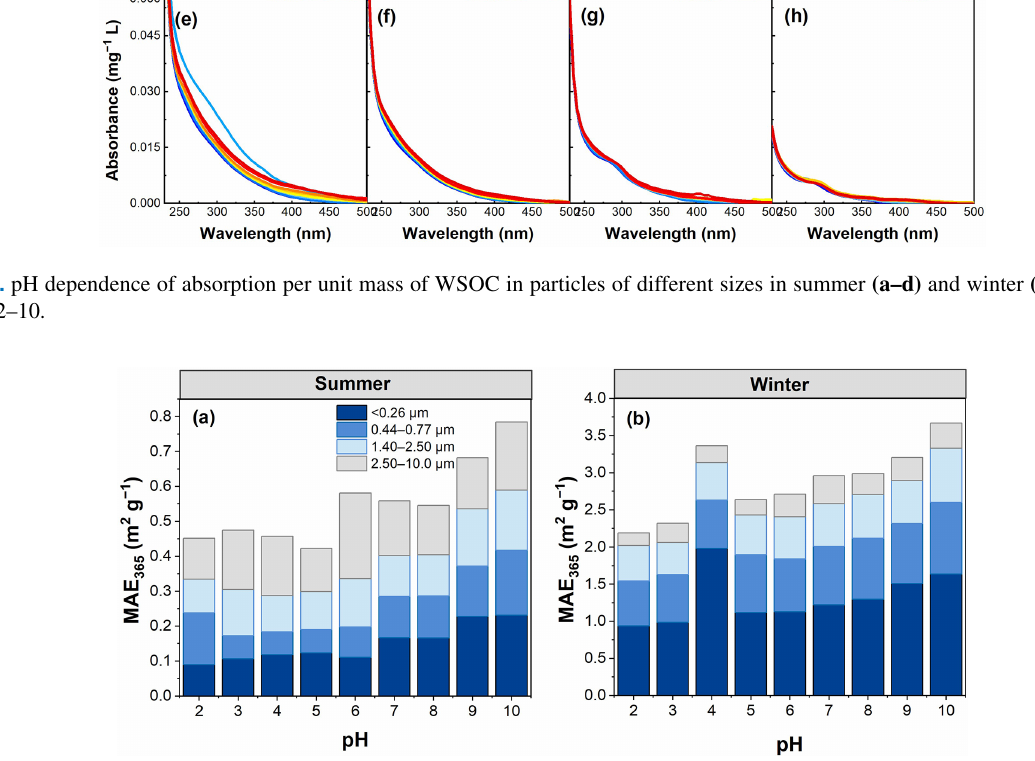
Figure 4. pH dependence of MAE 365 for WSOC in particles of different sizes in (a) summer and (b) winter in the pH range of